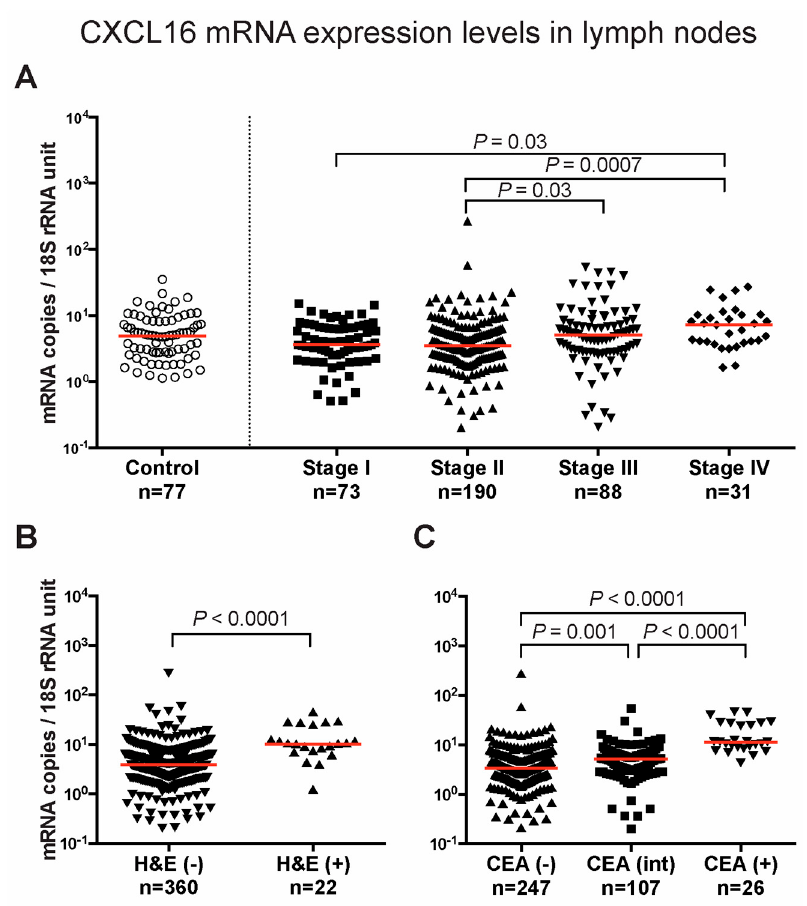
Figure 2. CXCL16 mRNA expression levels in lymph nodes. ( A ) CXCL16 mRNA levels in lymph nodes from non-cancerous disease patients (Control) and colon cancer patients in di ff erent TNM stages (Stage I–IV). ( B ) CXCL16 mRNA levels in non-metastatic (H&E( − )) and metastatic (H&E( + )) lymph nodes. In ( C ) lymph nodes were divided into three groups according to their CEA mRNA levels; CEA( − ) = CEA mRNA levels < 0.013 copies / 18S rRNA unit, CEA(int) = intermediate CEA mRNA levels, that is 0.013–3.67 copies / 18S rRNA unit, and CEA( + ) = CEA mRNA levels > 3.67 copies / 18S rRNA unit. Red horizontal lines indicate median values. n = number of lymph nodes. P -values were calculated by Kruskal–Wallis non-parametric ANOVA followed by post hoc Dunn’s test for multiple comparisons in ( A , C ) and by two-tailed Mann–Whitney test for comparison between expression levels in ( B